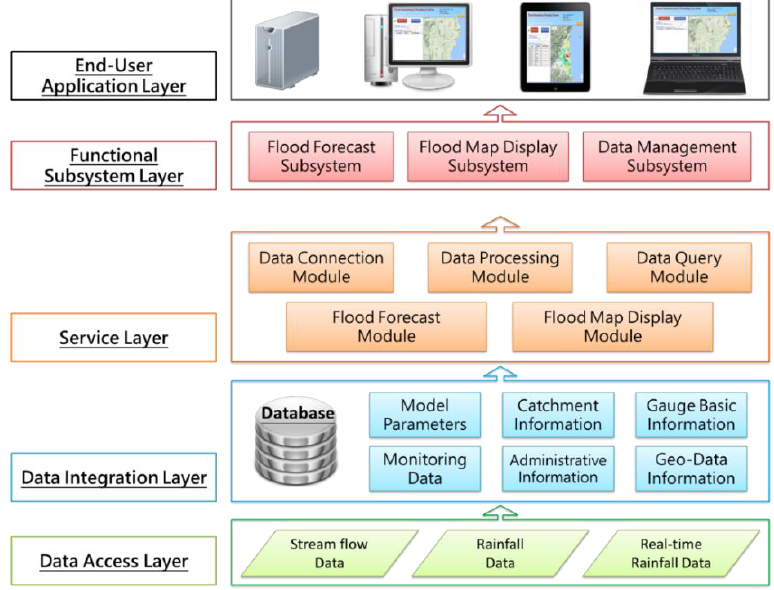
Figure 1. Architecture of the flood early warning system for river basins.